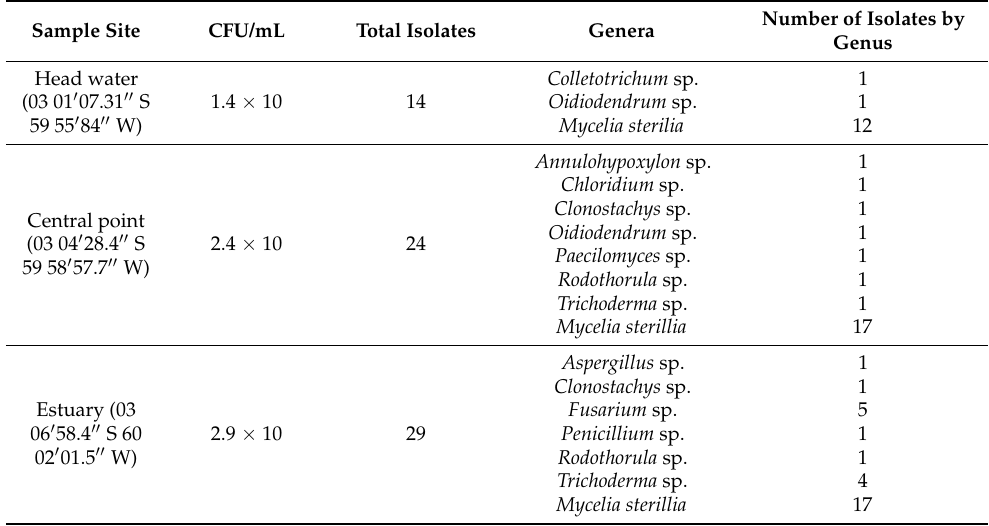
Table 2. Number of CFU (colony forming units)/mL, the total number of fungal isolates and the total number of isolates of aerobic fungi from three different sampling sites on the Mind ú stream, Manaus, Amazonas. CFU = colony forming